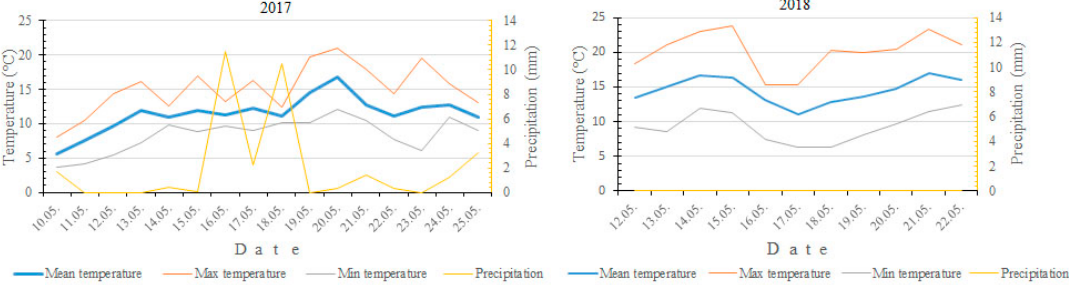
Figure 2. Temperatures and precipitation during flowering phenophases of pear cultivars ‘Ingeborg’ and ‘Celina’ in 2017 and 2018.